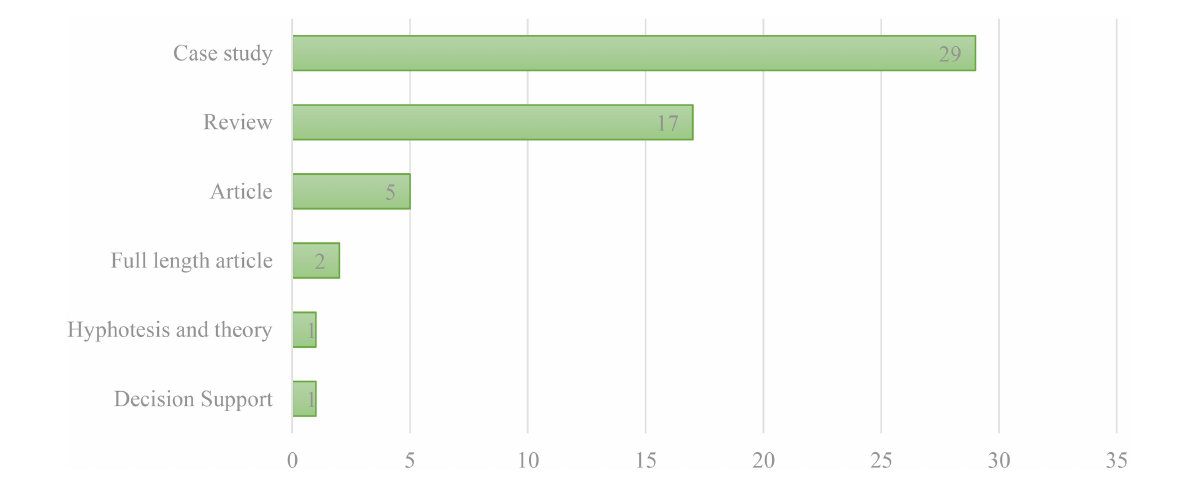
FIGURE5 Classification of scientific papers. Source: our elaboration.